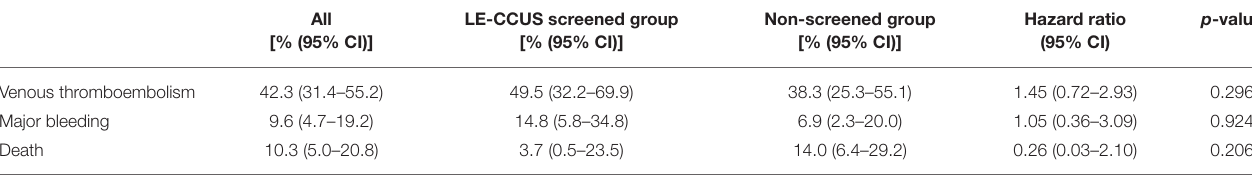
TABLE 2 | Cumulative incidence of events at 21 days according to systematic screening or not for LE-DVT, and comparison by unadjusted Cox models, with non-screened group as reference.